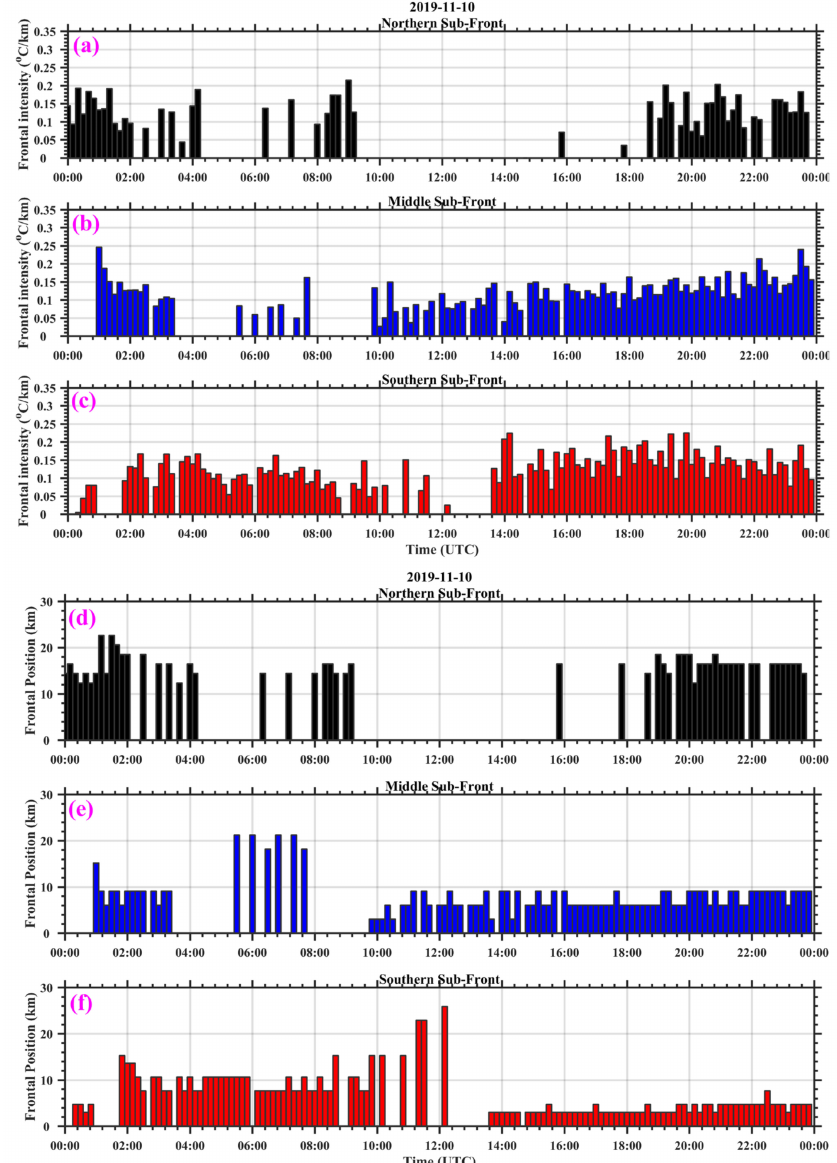
Figure 8. Same as Figure 7, but for 10 November